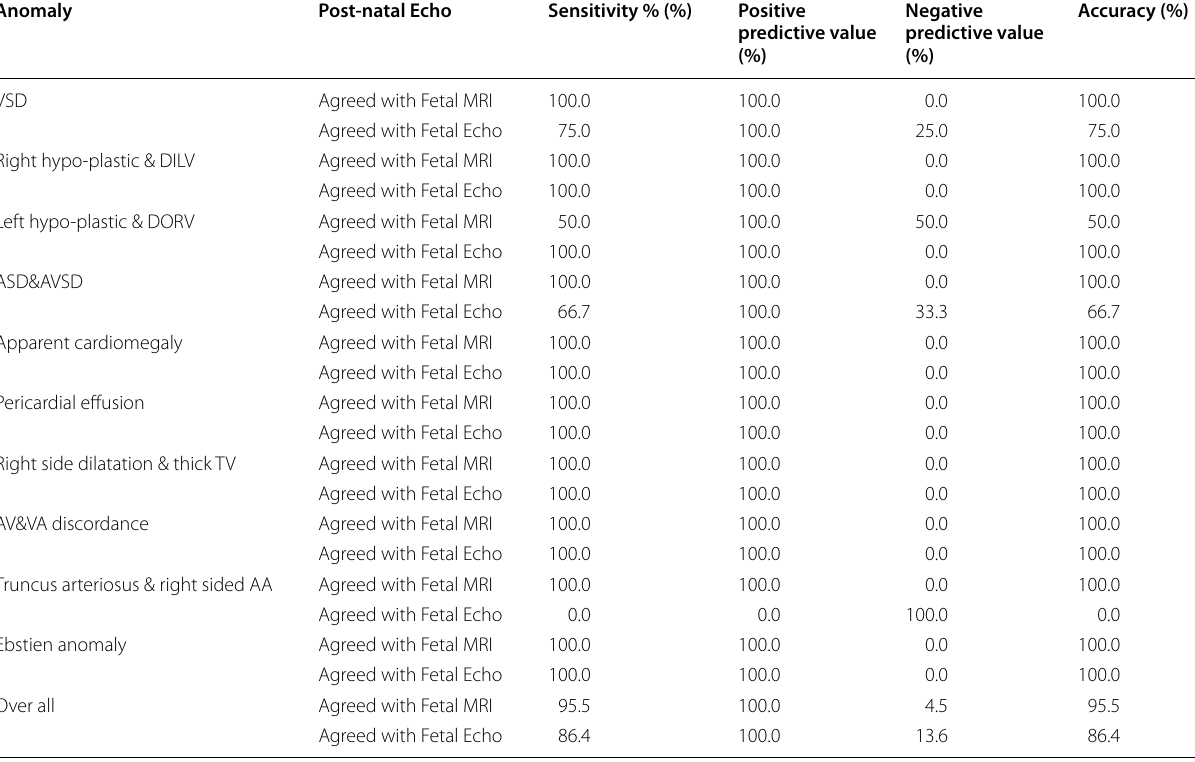
Table 5 Sensitivity, positive predictive value, negative predictive value and accuracy of Fetal MRI and Fetal Echo regarding to individual and over all cardiac